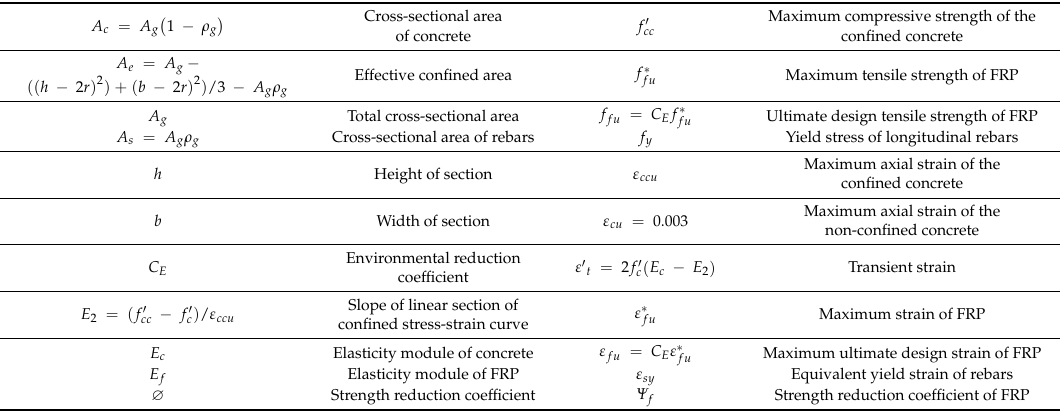
Table 1. Notations used in this